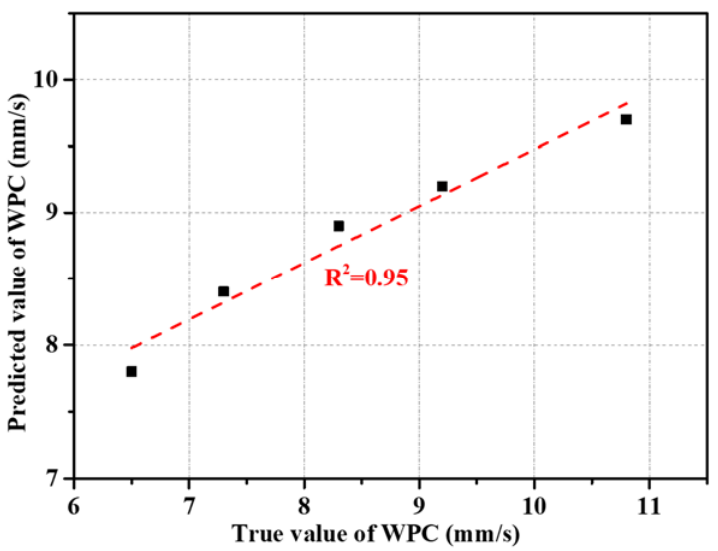
Figure 12. Correlation between measured WPC (MX1 ‐ 5) and predicted WPC at PF of 160–200 mm and P/A of 0.20.